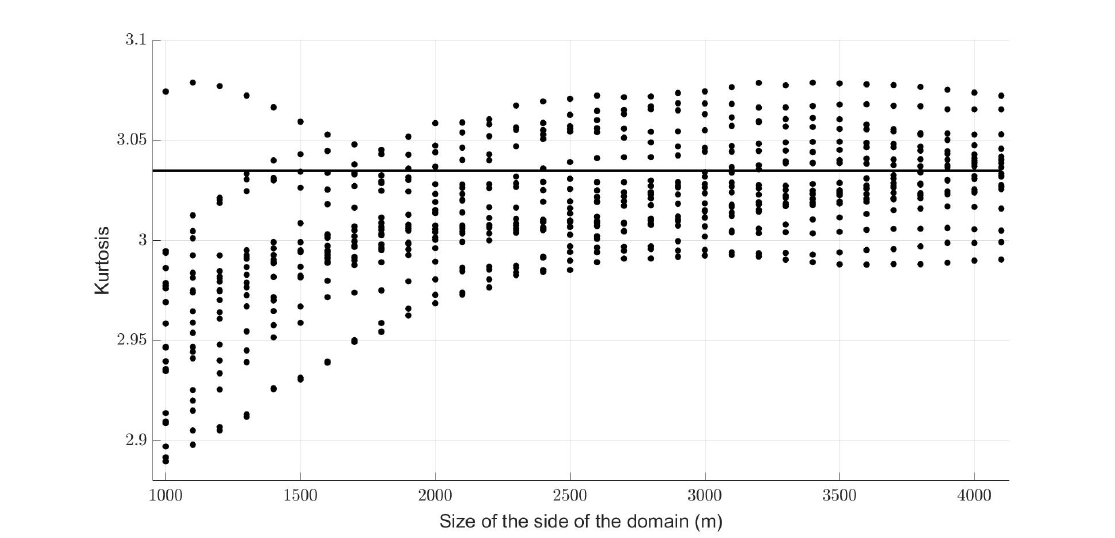
Figure 11. Same as Figure 10 with a zoom-in on square sides ranging from 1000 to 4130 m.